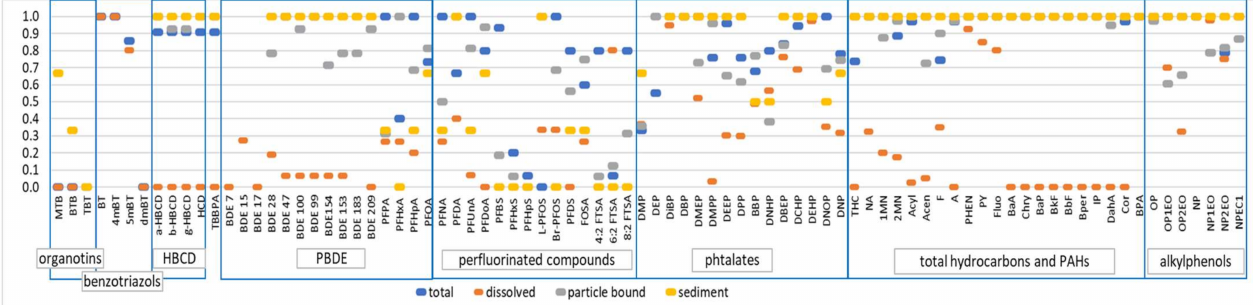
Figure 2. Quantification frequency (y-axis, in a fraction of the collected samples) of the targeted organic pollutants in the dissolved phase, particulate-bound phase and